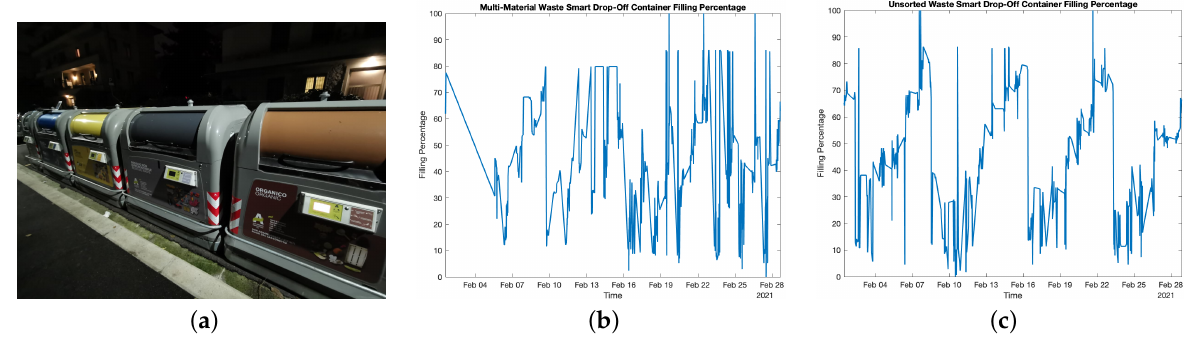
Figure 10. Smart drop-off container field tests: ( a ) smart drop-off container outdoor installed in the city of Florence, Italy; ( b ) filling level trend of multi-material waste smart drop-off container; ( c ) filling level trend of residual waste smart drop-off